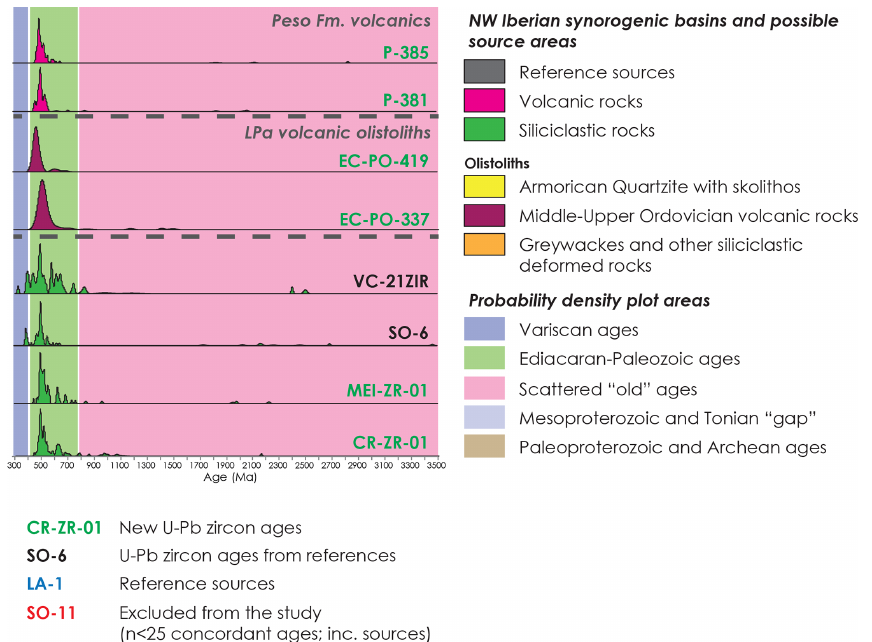
Figure 12. Age distribution plots of the Cluster 1 type populations: “Upper Parautochthon Middle Ordovician–Silurian volcanism”. See text and the Supplement for a detailed